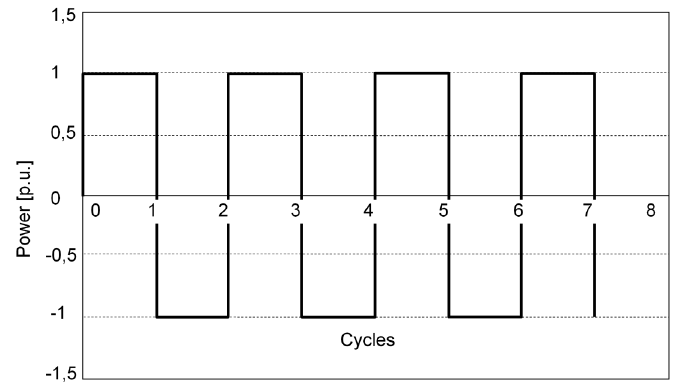
Figure 1. Charge–discharge in a standard cycle for ageing estimation.